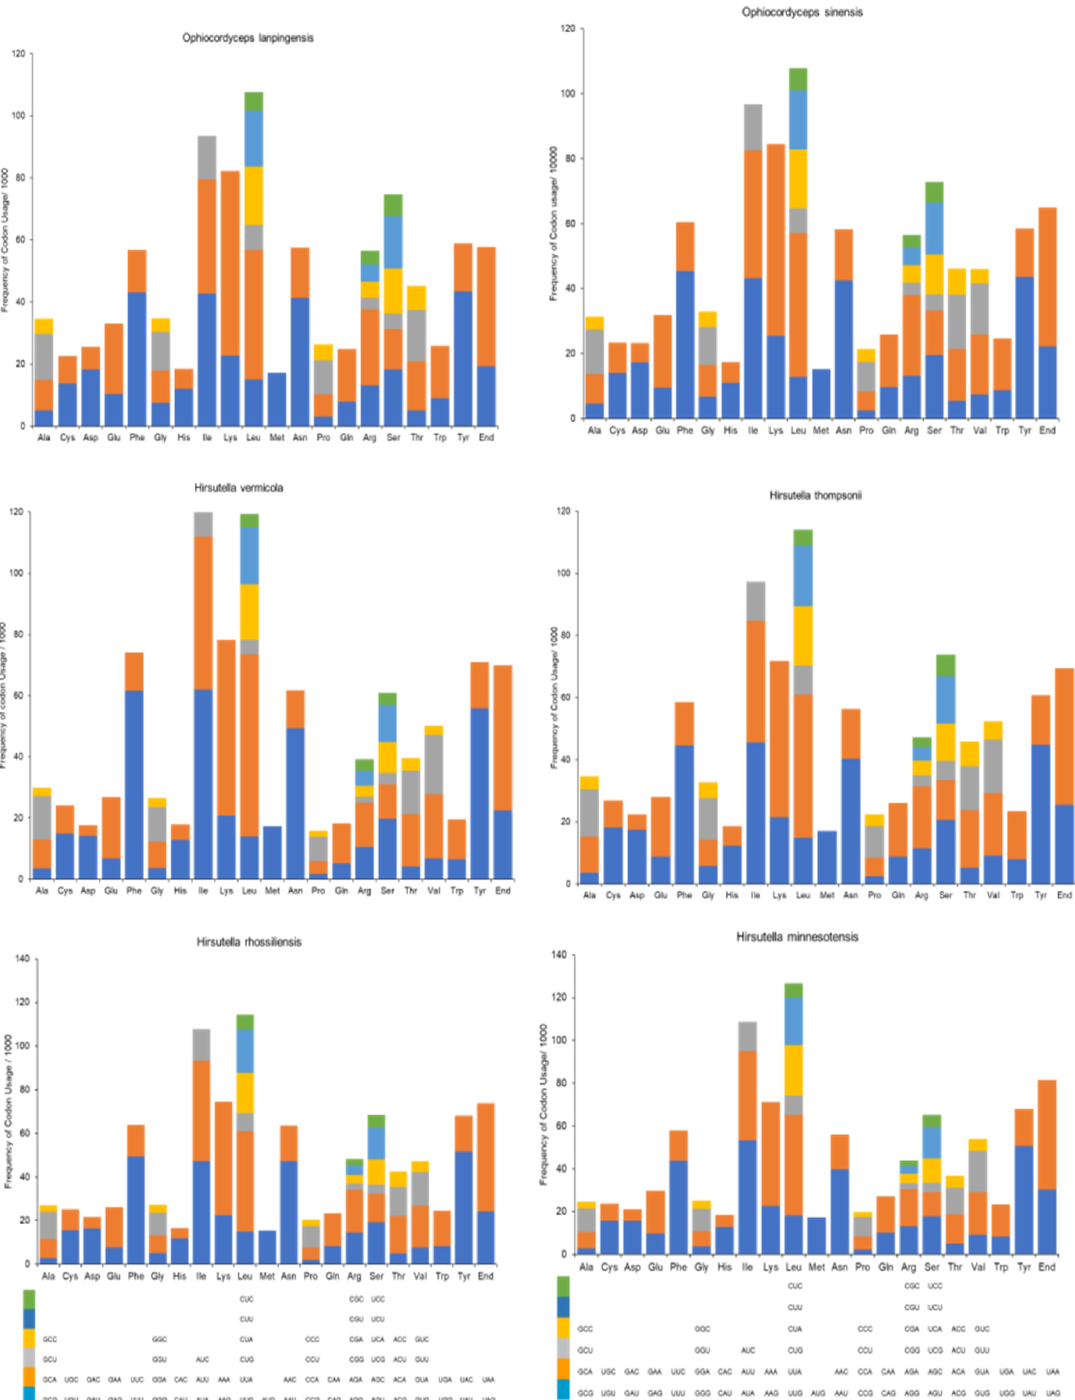
Figure 6. Codon usage analysis of the mitogenomes from six Ophiocordyceps species. Frequency of codon usage is plotted on the y axis.